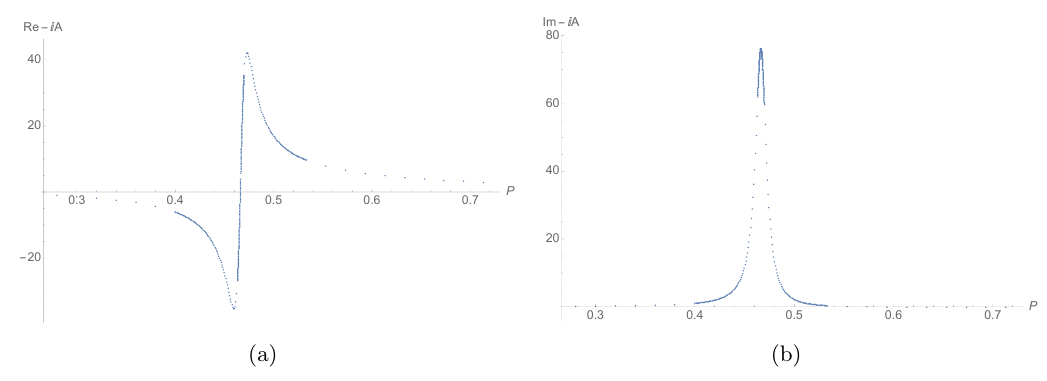
Figure 5 . Contributions to the real (left) and imaginary (right) parts of the amplitude (cid:0) i A (0) from a range of Liouville momentum P , after having already performed the z -integral in the domain D = fj z (cid:0) 1 j < 1 ; 0 < Re( z ) < 1 = 2 g . In this example we take ! = 1 : 4 + i(cid:15) , ! 1 = ! 2 = ! 3 = != 3, with (cid:15) = 0 : 01, and the Virasoro conformal block was computed up to order 12 in its q expansion.